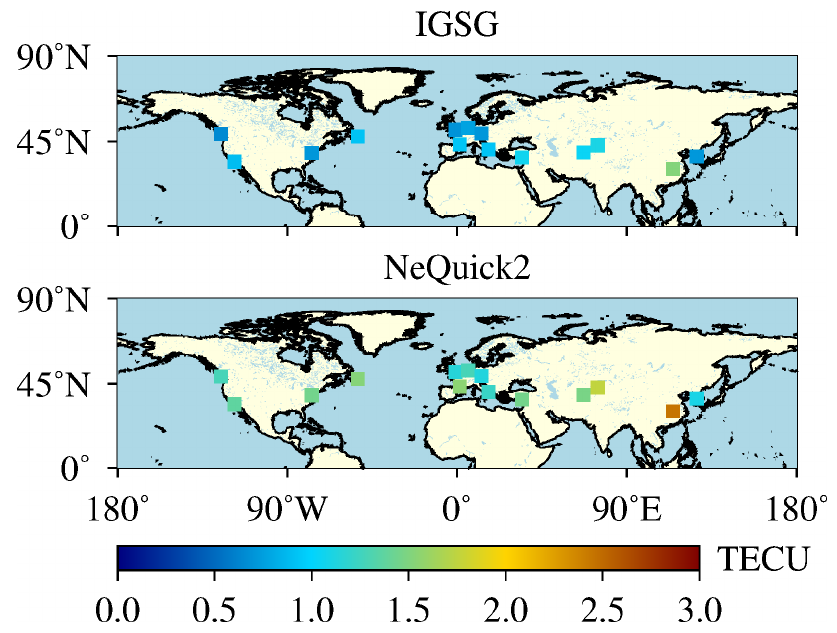
Figure 13. The STD of dSTEC assessment results of each station for IGSG and NeQuick2 during the test period.